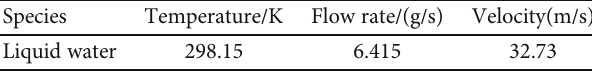
Figure 7: Calculation domain and meshing.